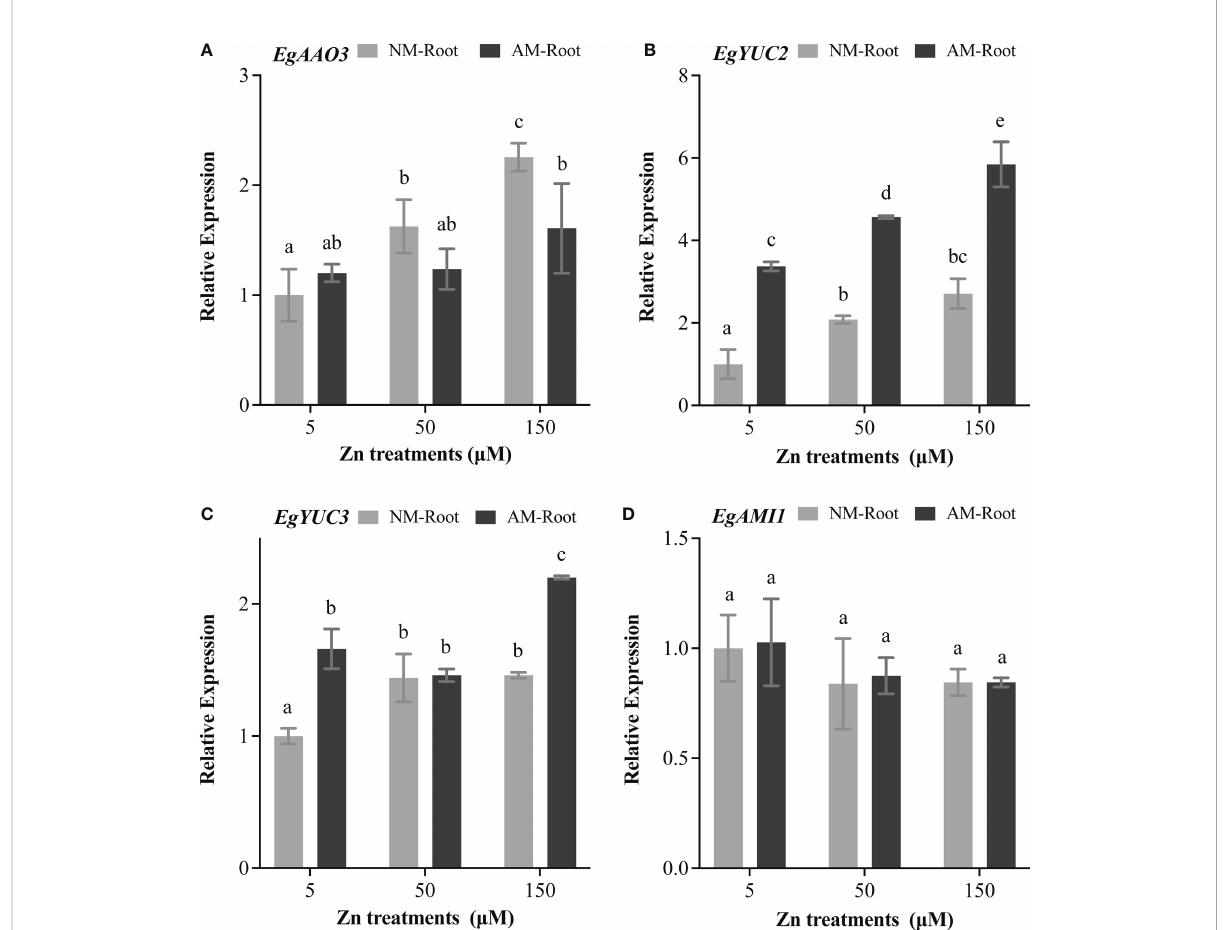
FIGURE 5 Expression pro fi les of auxin biosynthesis – related genes. The relative expression of EgAAO3 (A) , EgYUC2 (B) , EgYUC3 (C) , and EgAMI1 (D) was calculated by the 2 − DD CT method using the EgUBI3 as a normalizer. For each gene, the expression level in NM roots with 5 m M Zn was de fi ned as 1. NM-Root, the root of non-mycorrhizal plants; AM-Root, the root of mycorrhizal plants. Values were indicated as mean ± SE. Different letters on the histograms indicated signi fi cant differences ( P <